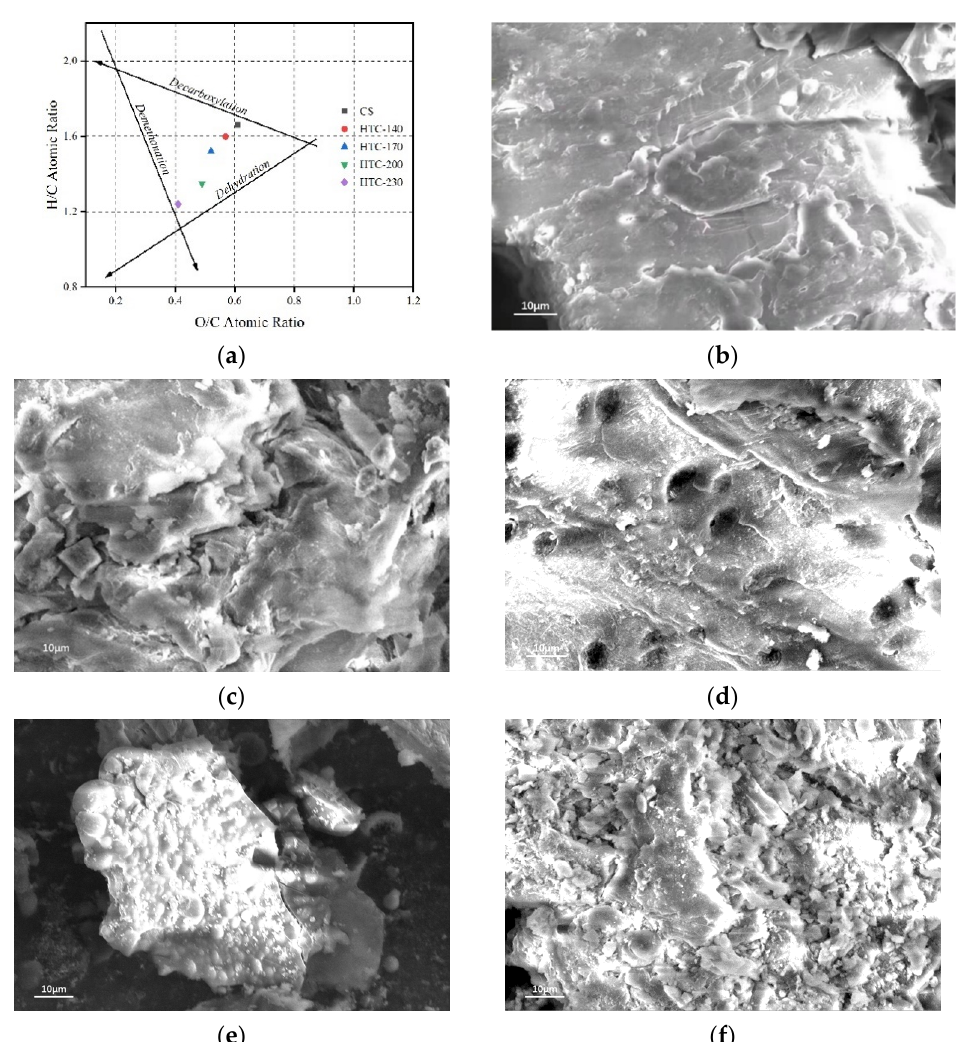
Figure 4. Van Krevelen diagram ( a ) and SEM images of CS ( b ), HTC-140 ( c ), HTC-170 ( d ), HTC-200 ( e ) and HTC-230 ( f ).